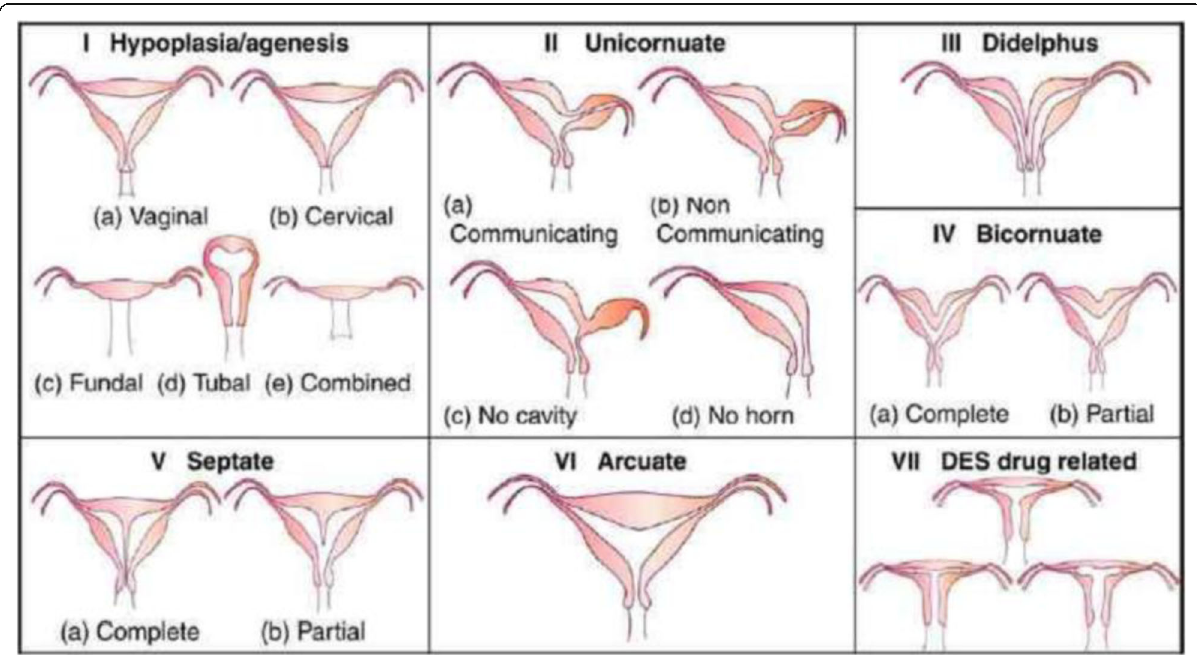
Fig. 1 Classification of congenital uterine anomalies as described by the American Fertility Society